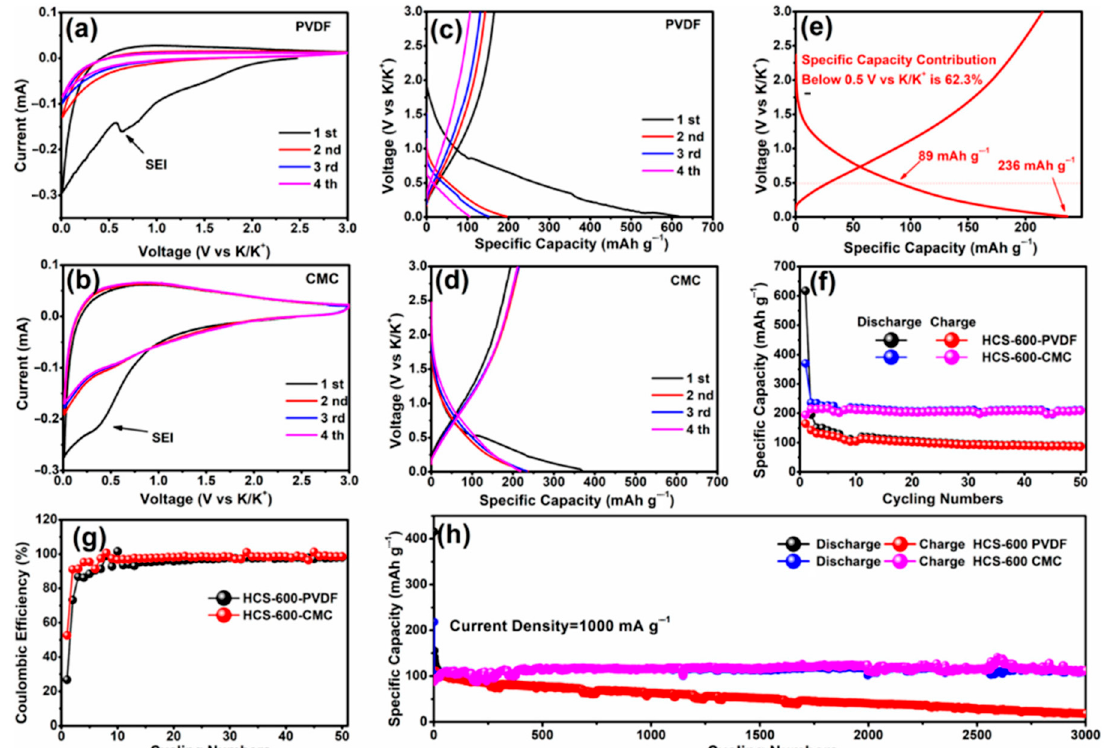
Figure 11. CV curves of HCS-600 using ( a ) PVDF and ( b ) CMC binders. Galvanostatic charge– discharge profiles of HCS-600 using ( c ) PVDF and ( d ) CMC binders. ( e ) Second discharge specific capacity contribution of HCS-600 using the CMC binder below 0.5 V vs. K/K + . ( f ) Cycling perfor- mance and ( g ) Coulombic efficiency of HCS-600 using PVDF and CMC binders tested at 50 mA/g. ( h ) Long-term cycling performance tested at 1000 mA/g. ( a – h ) Reproduced with permission from Ref. [155]. Copyright 2019 American Chemical